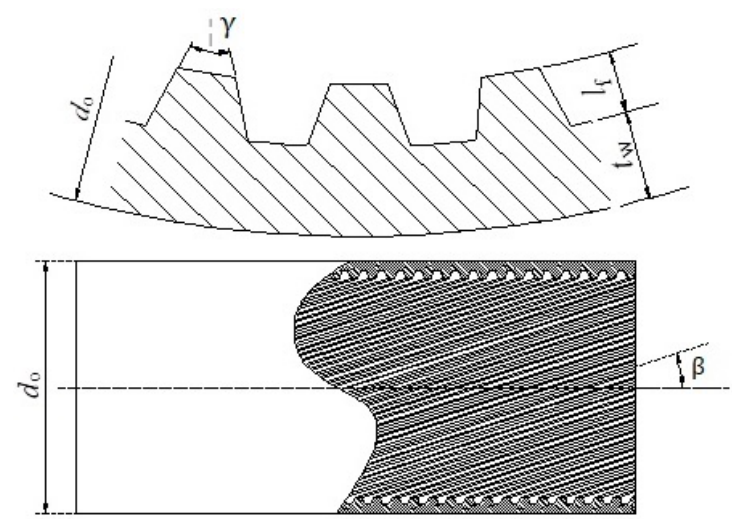
Figure 4. Physical presentation of the geometrical